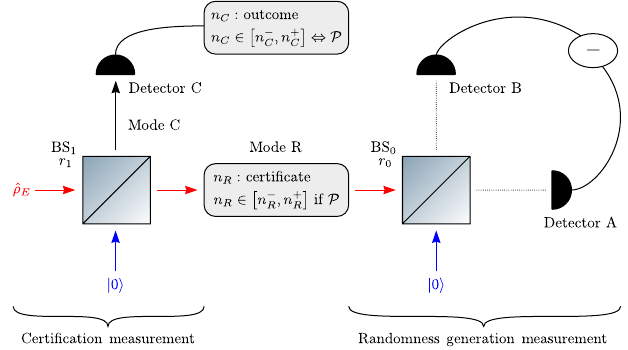
FIG. 1. Scheme for our SDI protocol. An unknown light source ˆ ρ is mixed with a trusted vacuum on a beam splitter (BS) with E reflectivity r 1 to perform a certification measurement. The mea- sured outcome at detector C is subject to a test P that passes if the ; n þ outcome lies within a certain range ½ n − (cid:2) . Upon passing the test, C C we certify a photon number n in mode R that impinges onto the R randomness generation measurement except with probability ϵ fail